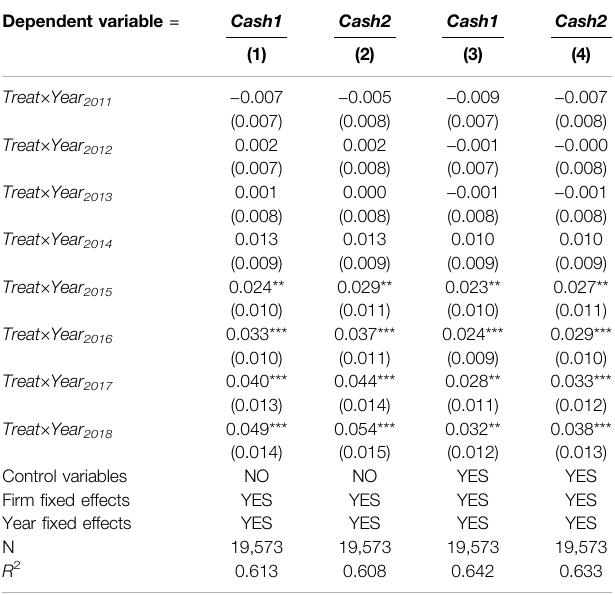
TABLE 4 | The parallel trend and dynamic effects of environmental regulation on corporate cash